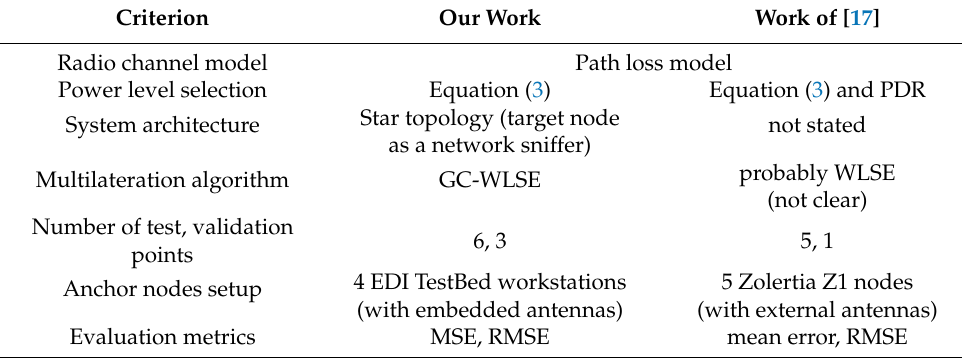
Table 1. Comparison between our work and work done in [17].